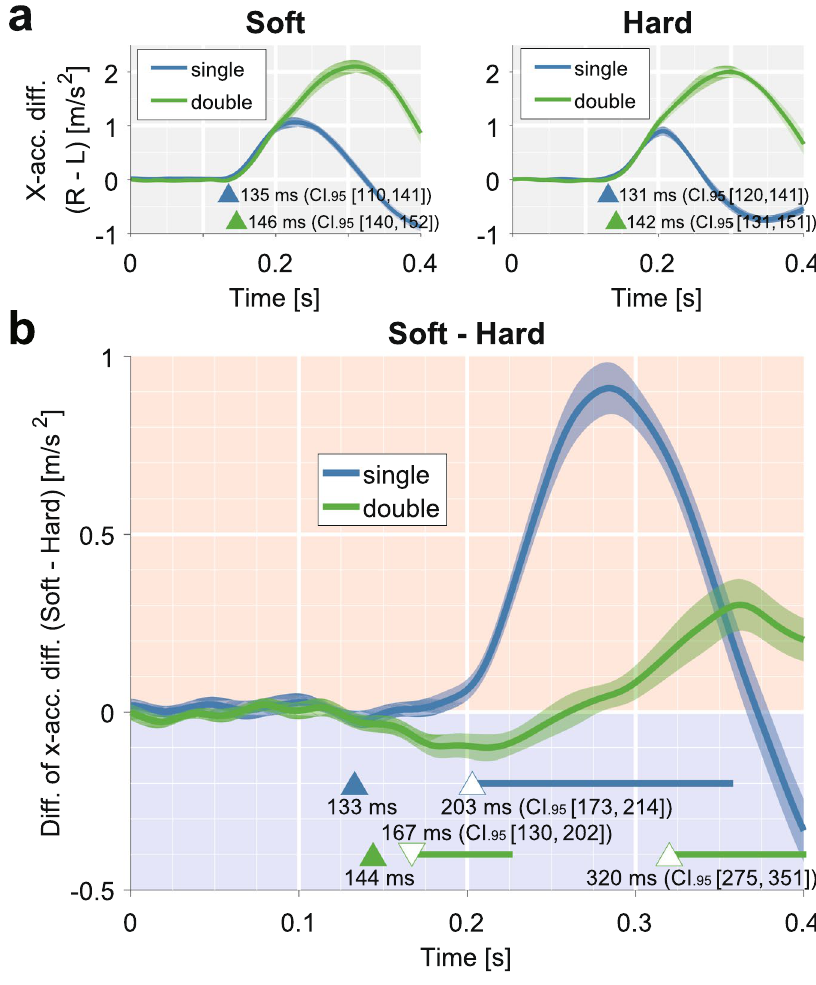
Figure 2. Mean adjustment responses (horizontal acceleration of the hand) of all participants ( N = 20). ( a ) Responses for the soft-edge target (left panel) and the hard-edge target (right panel). The responses to the single- and double-drift targets are shown with blue and green lines, respectively ( M ± SEM ). The time zero denotes the onset of the target motion. The triangles indicate the adjustment response onset ( p < 0.01 with one- tailed successive t -tests). ( b ) The differences between the correcting responses of the soft- and hard-edge targets under double-drift (green curve) and single-drift (blue curve) conditions ( M ± SEM ). The positive deflection indicates the effect of MIPS. The filled triangles indicate the mean of the adjustment response onset times for the soft- and hard-edge targets. The bottom horizontal lines denote the periods during which the responses were significantly deflected from zero, and the open triangles indicate those onsets ( p < 0.01 with one-tailed successive t -tests; the directions of the triangles indicate positive and negative deflection). The 95% confidence intervals (CIs) were obtained by bootstrapping across participants (see Methods and Supplementary Fig.